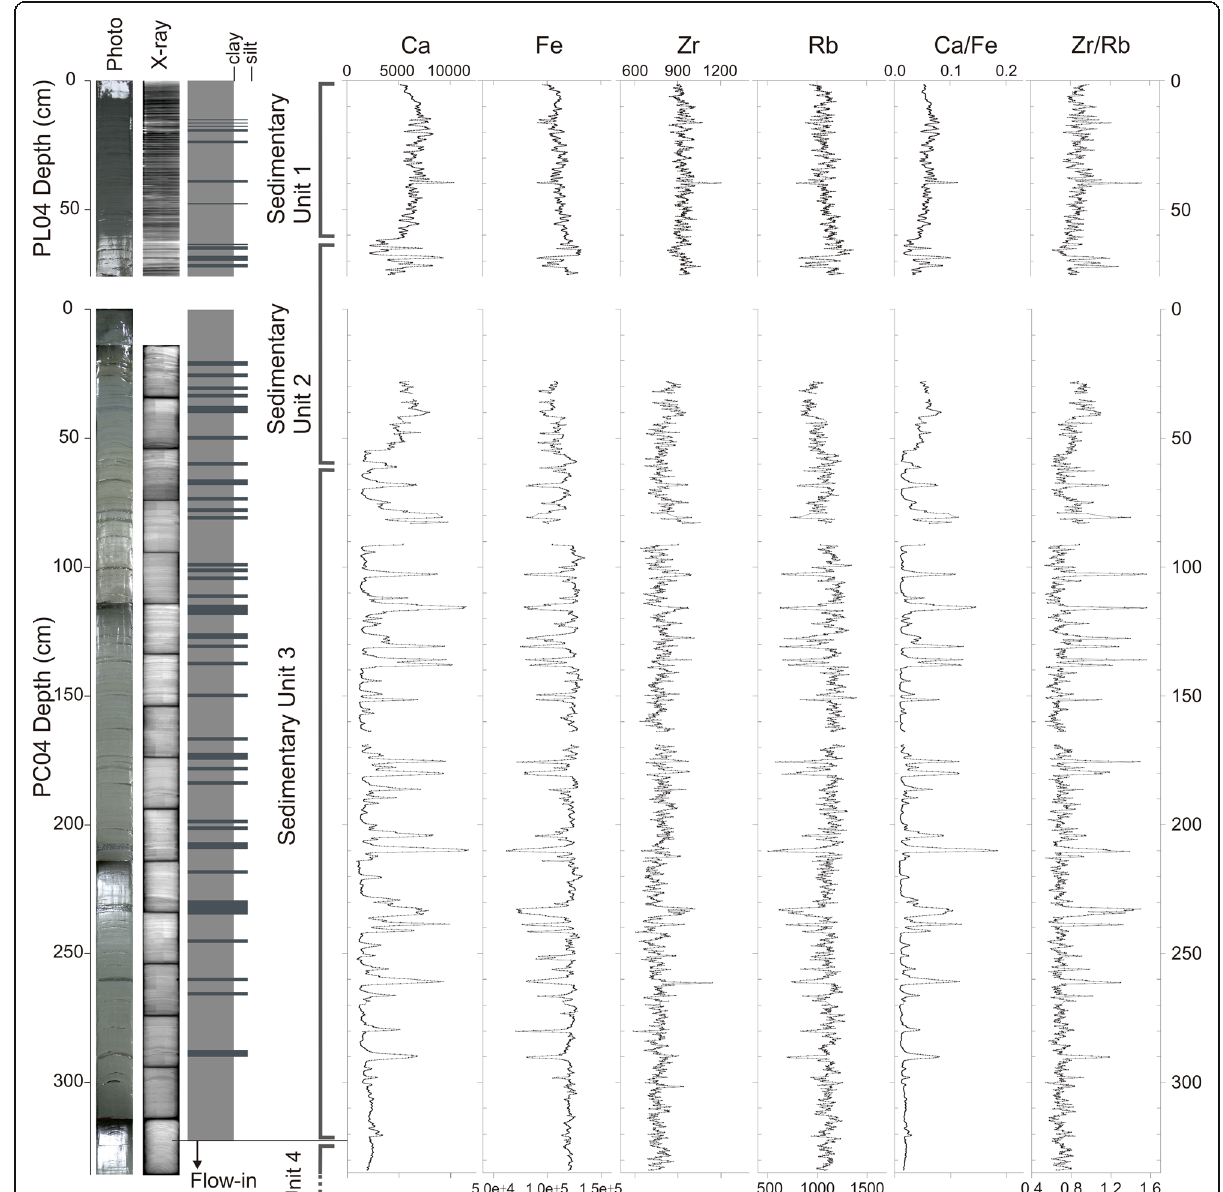
Fig. 3 Core photographs, radiographs, lithological logs, and Itrax geochemical data (Ca, Fe, Zr, Rb, Ca/Fe, and Zr/Rb) of pilot core PL04 and piston core PC04. Sedimentary unit 1, 0 – 62.0 cm depth in PL04; sedimentary unit 2, 62.0 – 76.5 cm depth in PL04 and 0 – 55.0 cm depth in PC04; sedimentary unit 3, below 55.0 cm depth in PC04. Core PC04 shows basal flow-in below 322.0cm